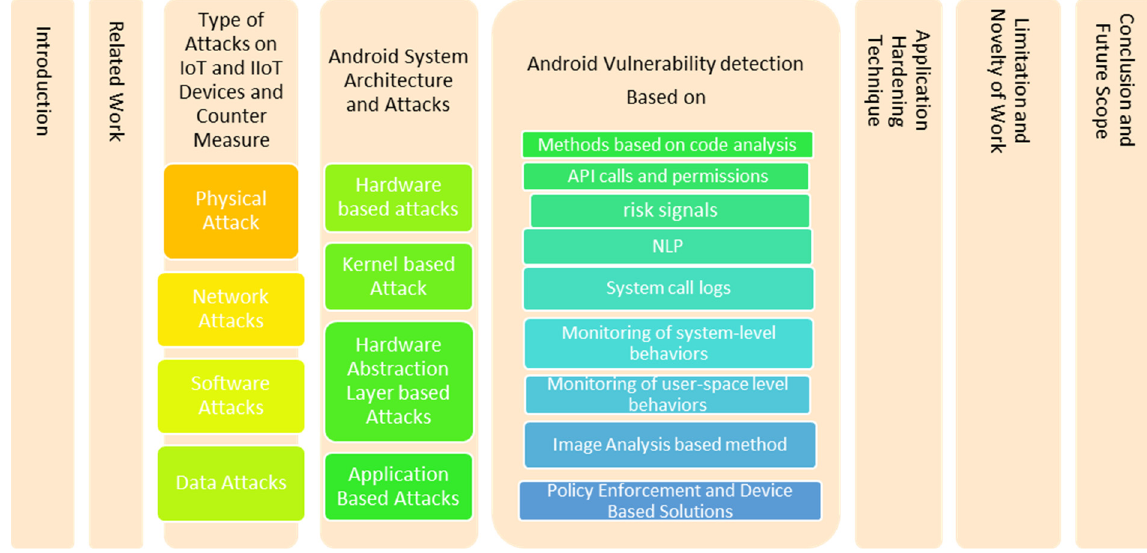
Figure 2. Taxonomy of presented